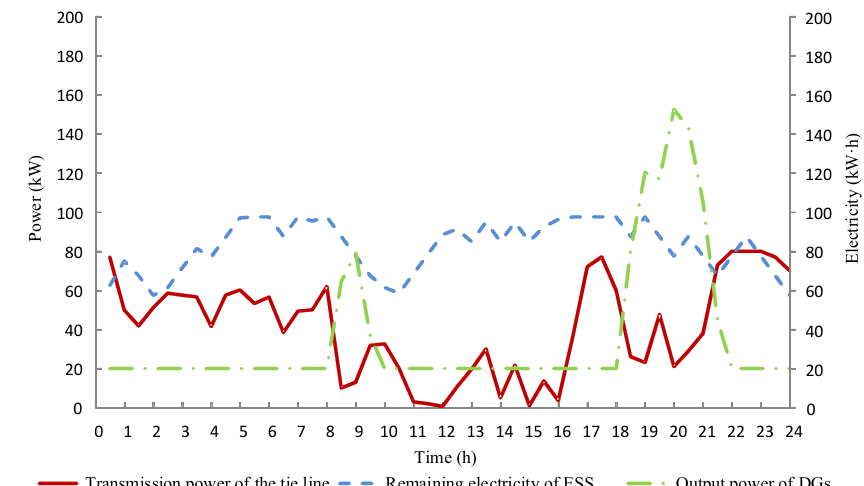
Figure 11. Realized operation results under Strategy A.